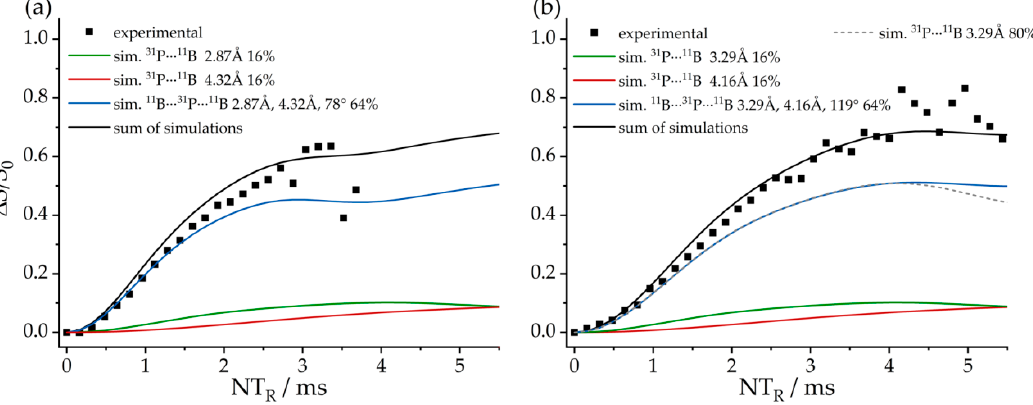
Figure 29. Experimental and simulated 31 P { 11 B} REAPDOR curves for ( a ) 8 and ( b ) 7 , including the simulated components of the corresponding isotopologues based on the dipolar geometries as indicated.